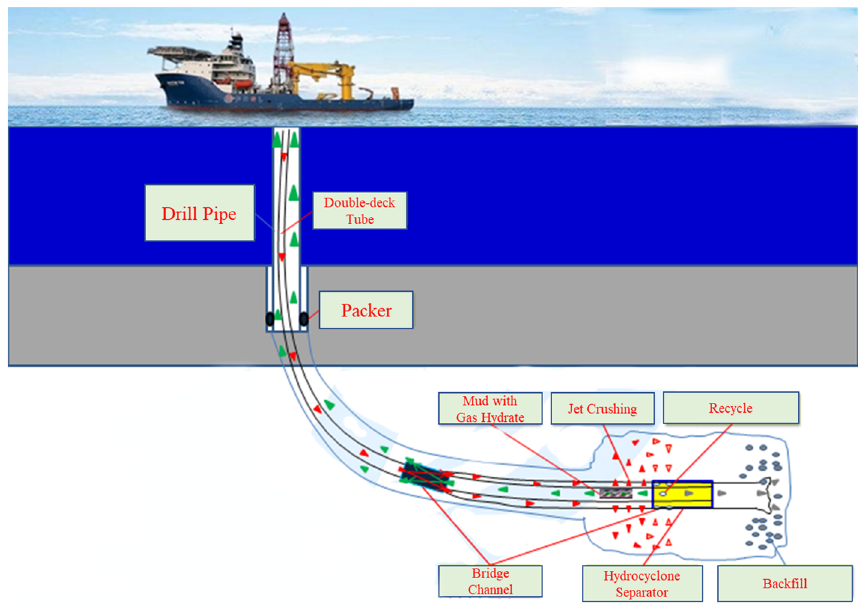
Fig. 1 Technological process for solid fluidization mining of NGH from double-layered pipes